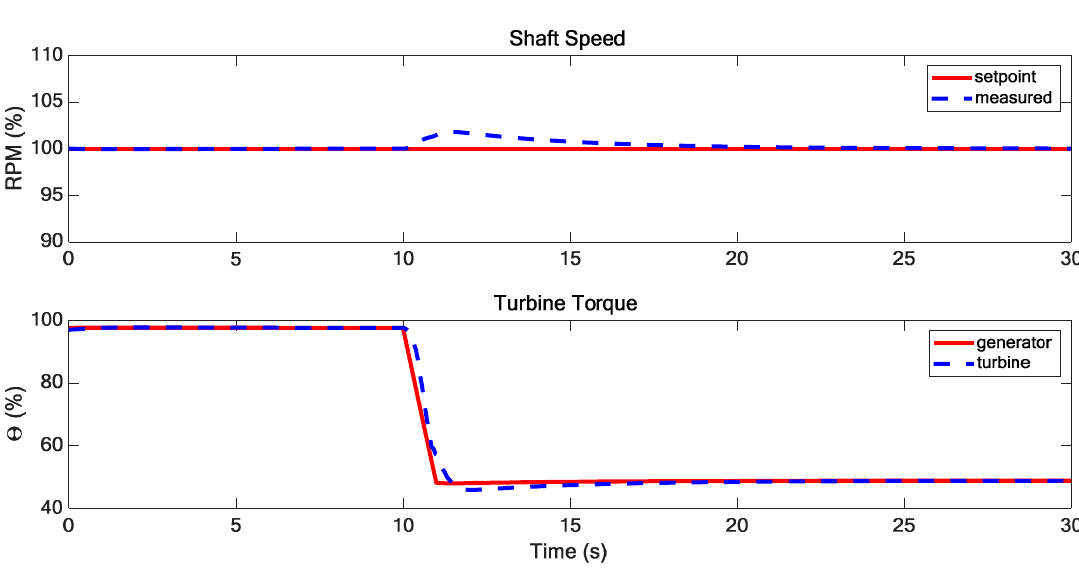
Figure 10. Closed response to falling step.